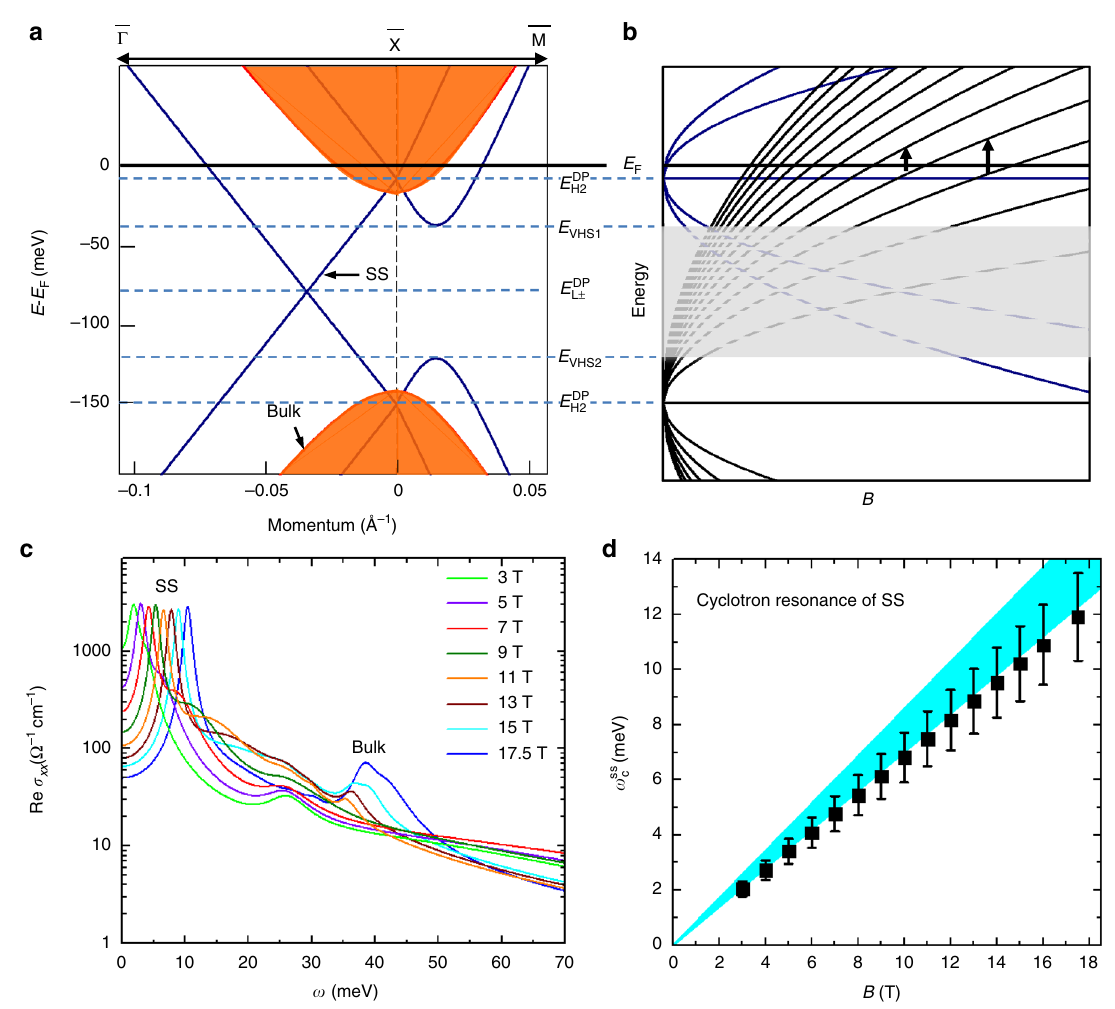
Fig. 4 IR conductivity of SS in magnetic fi elds. a A schematic of the SS band structure ( dark blue ) and that of the bulk ( red ) along two high-symmetry directions for one of the four Dirac cones inside the surface Brillouin zone. E DP cones located at the X points and the Dirac nodes along the Γ X line, respectively. E VHS1 and E VHS2 are energies of the two Van Hove singularities in the band structure. b A schematic of LLs of the SS in the same energy scale as that in a . While the LLs between E VHS1 and E VHS2 in the gray-shaded area have nontrivial dispersions 32 (not shown here), the LLs near E F are well approximated by LLs of two independent Dirac cones at E DP dashed lines in the shaded area. The CR of the SS associated with the Dirac cone at E DP conductivity Re σ xx ( ω ) in several magnetic fi elds that are used to simulate the R ( ω , B ) spectra below 70 meV. The strong peak below 15 meV in Re σ xx ( ω ) arises from CR of the SS, which represents the spatially averaged 3D optical conductivity of the SS within the IR penetration depth. d The CR energy of SS ω ss as a function of magnetic fi eld. The error bars represent the range of ω ss c within experimental uncertainties as discussed in Supplementary Note 2. The shaded area indicates the range of ω ss and ARPES